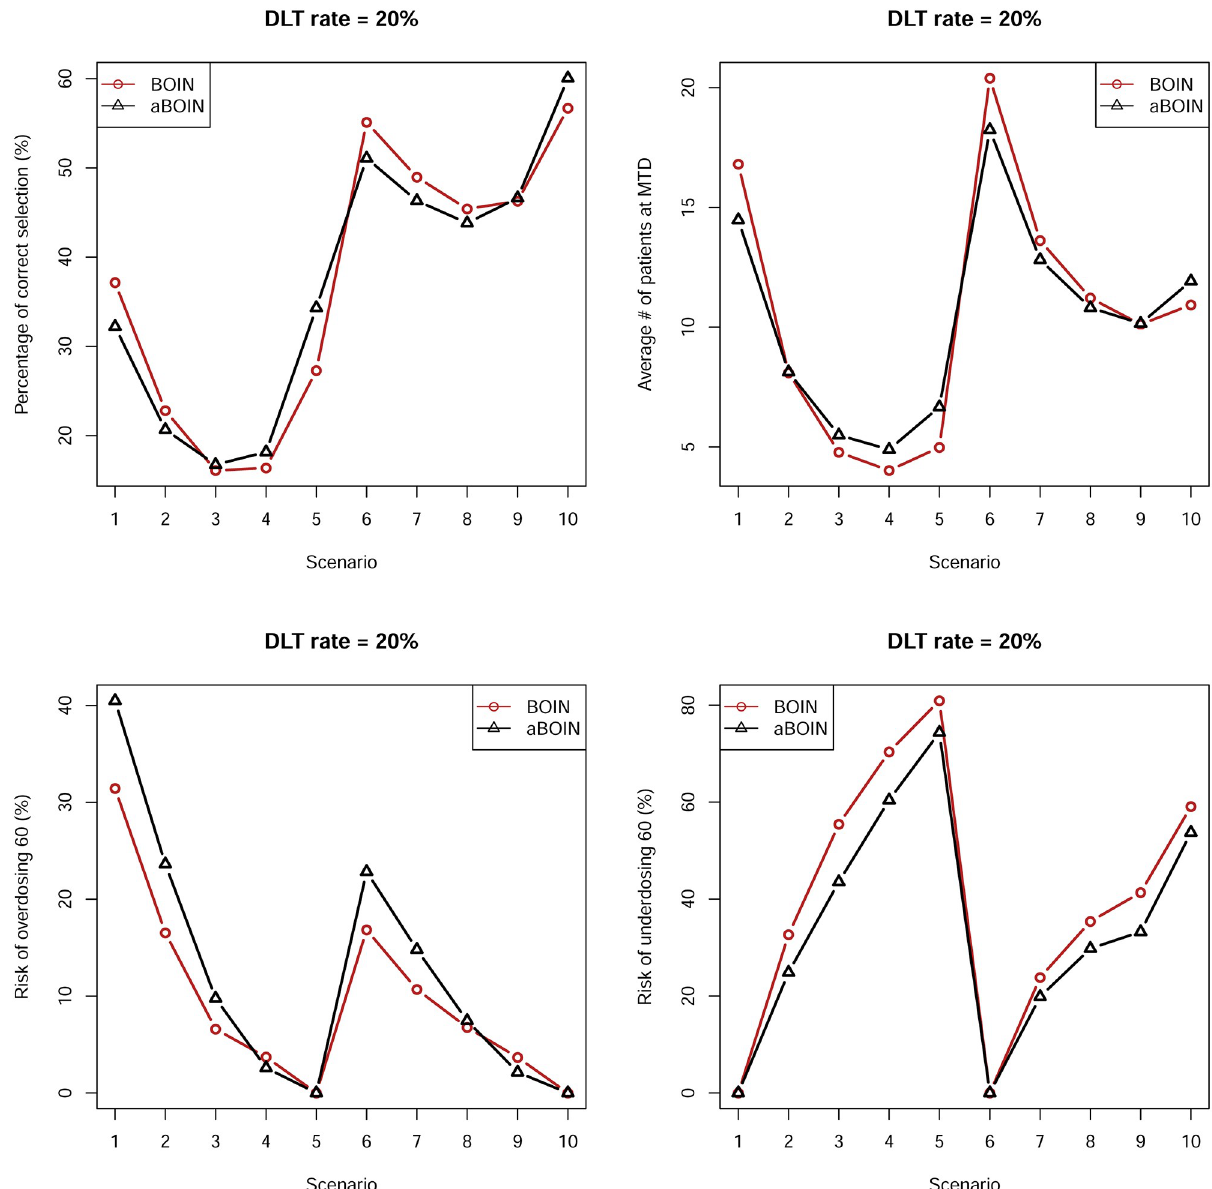
Fig 1. Operating characteristics of ten scenarios on the left panel (DLT 20%) of Table 2 by two competing methods BOIN and aBOIN.